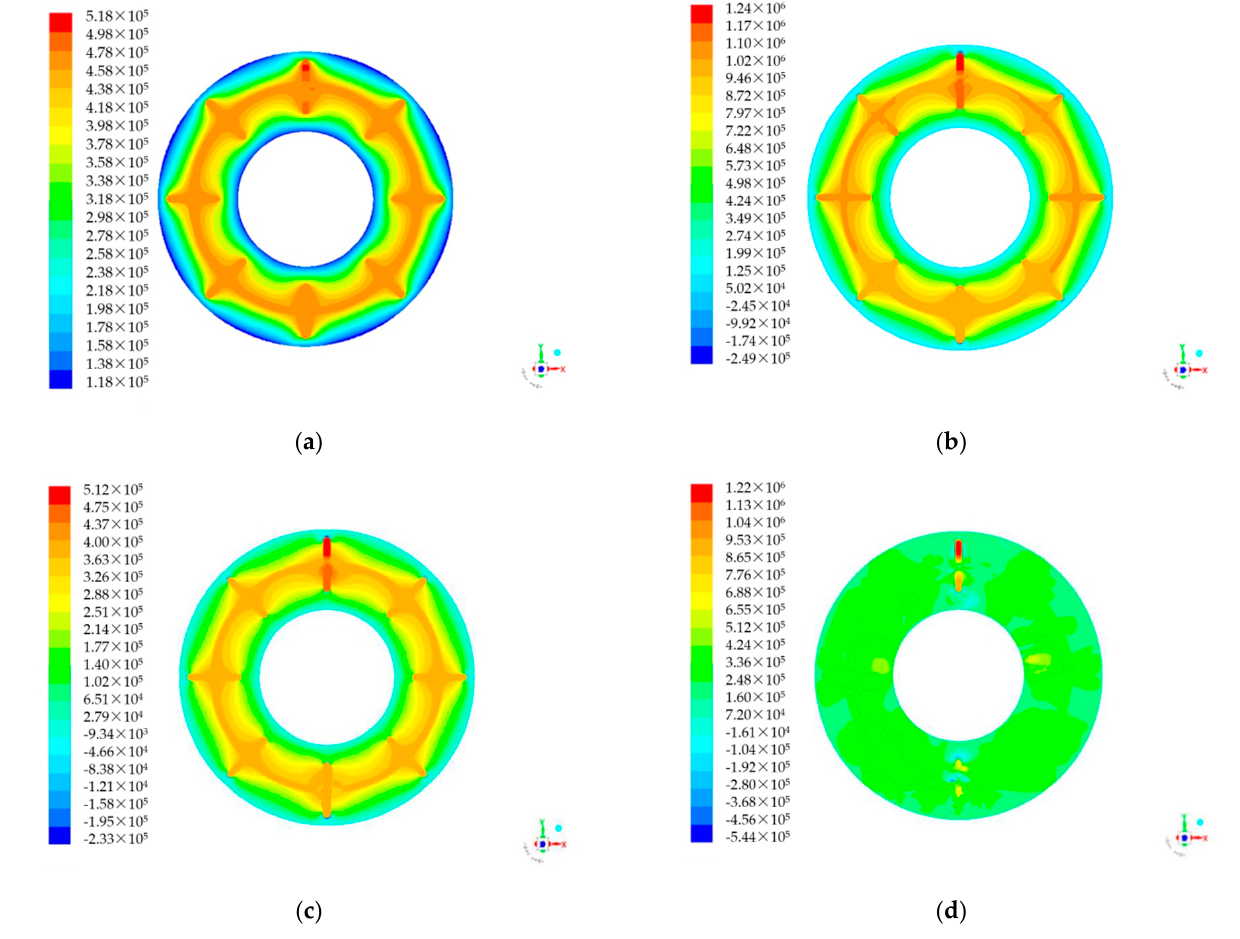
Figure 10. Pressure distribution of hydrostatic water film on static ring surface of star wheel shaft HTB: ( a ) p = 0.5 MPa, F gmax , h = 0.02 mm; ( b ) p = 1.2 MPa, F gmax , h = 0.04 mm; ( c ) p = 0.5 MPa, 1/3 F gmax , h = 0.07 mm; ( d ) p = 1.2 MPa, 1/3 F gmax , h = 0.10 mm.